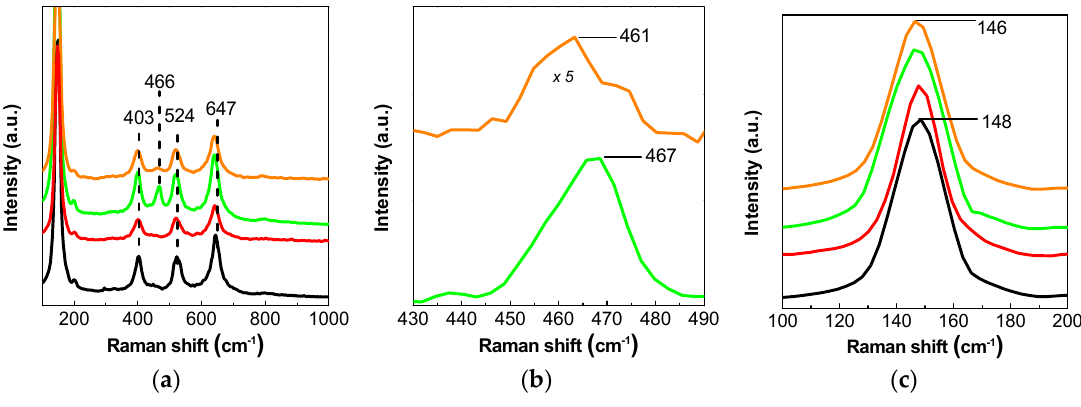
Figure 3. ( a ) Vibrational modes of Raman spectra of TiO 2 ( ─ ), Au/TiO 2 ( ─ ), TiO 2 ‐ 10%CeO 2 ( ─ ), and Au/TiO 2 ‐ 10%CeO 2 ( ─ ) samples; ( b ) Raman shift of the signal of cubic CeO 2 in TiO 2 ‐ 10%CeO 2 ( ─ ), and Au/TiO 2 ‐ 10%CeO 2 ( ─ ) samples; ( c ) Raman shift of the main E g vibrational mode of TiO 2 anatase in TiO 2 ( ─ ), Au/TiO 2 ( ─ ), TiO 2 ‐ 10%CeO 2 ( ─ ), and Au/TiO 2 ‐ 10%CeO 2 ( ─ ) samples.